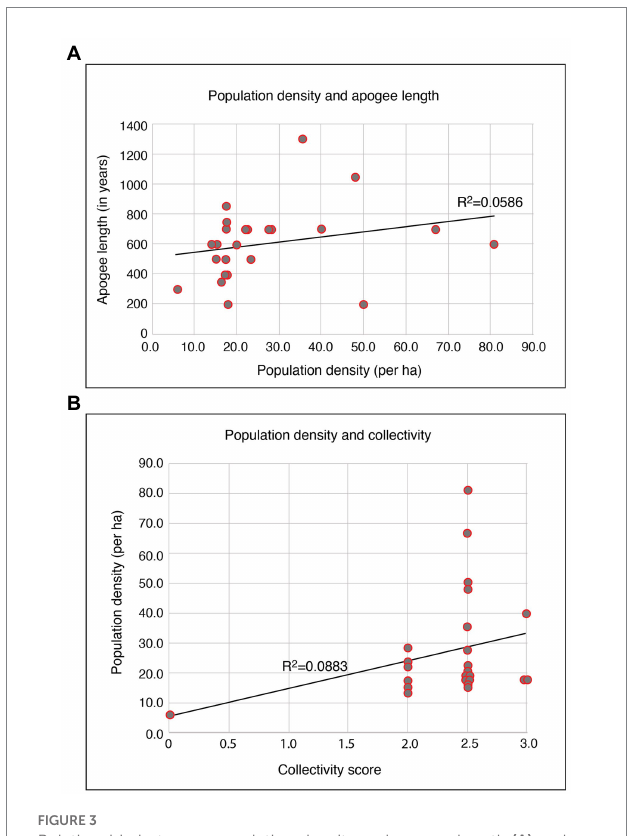
FIGURE 3 Relationship between population density and apogee length (A) and between collectivity score and population density (B)